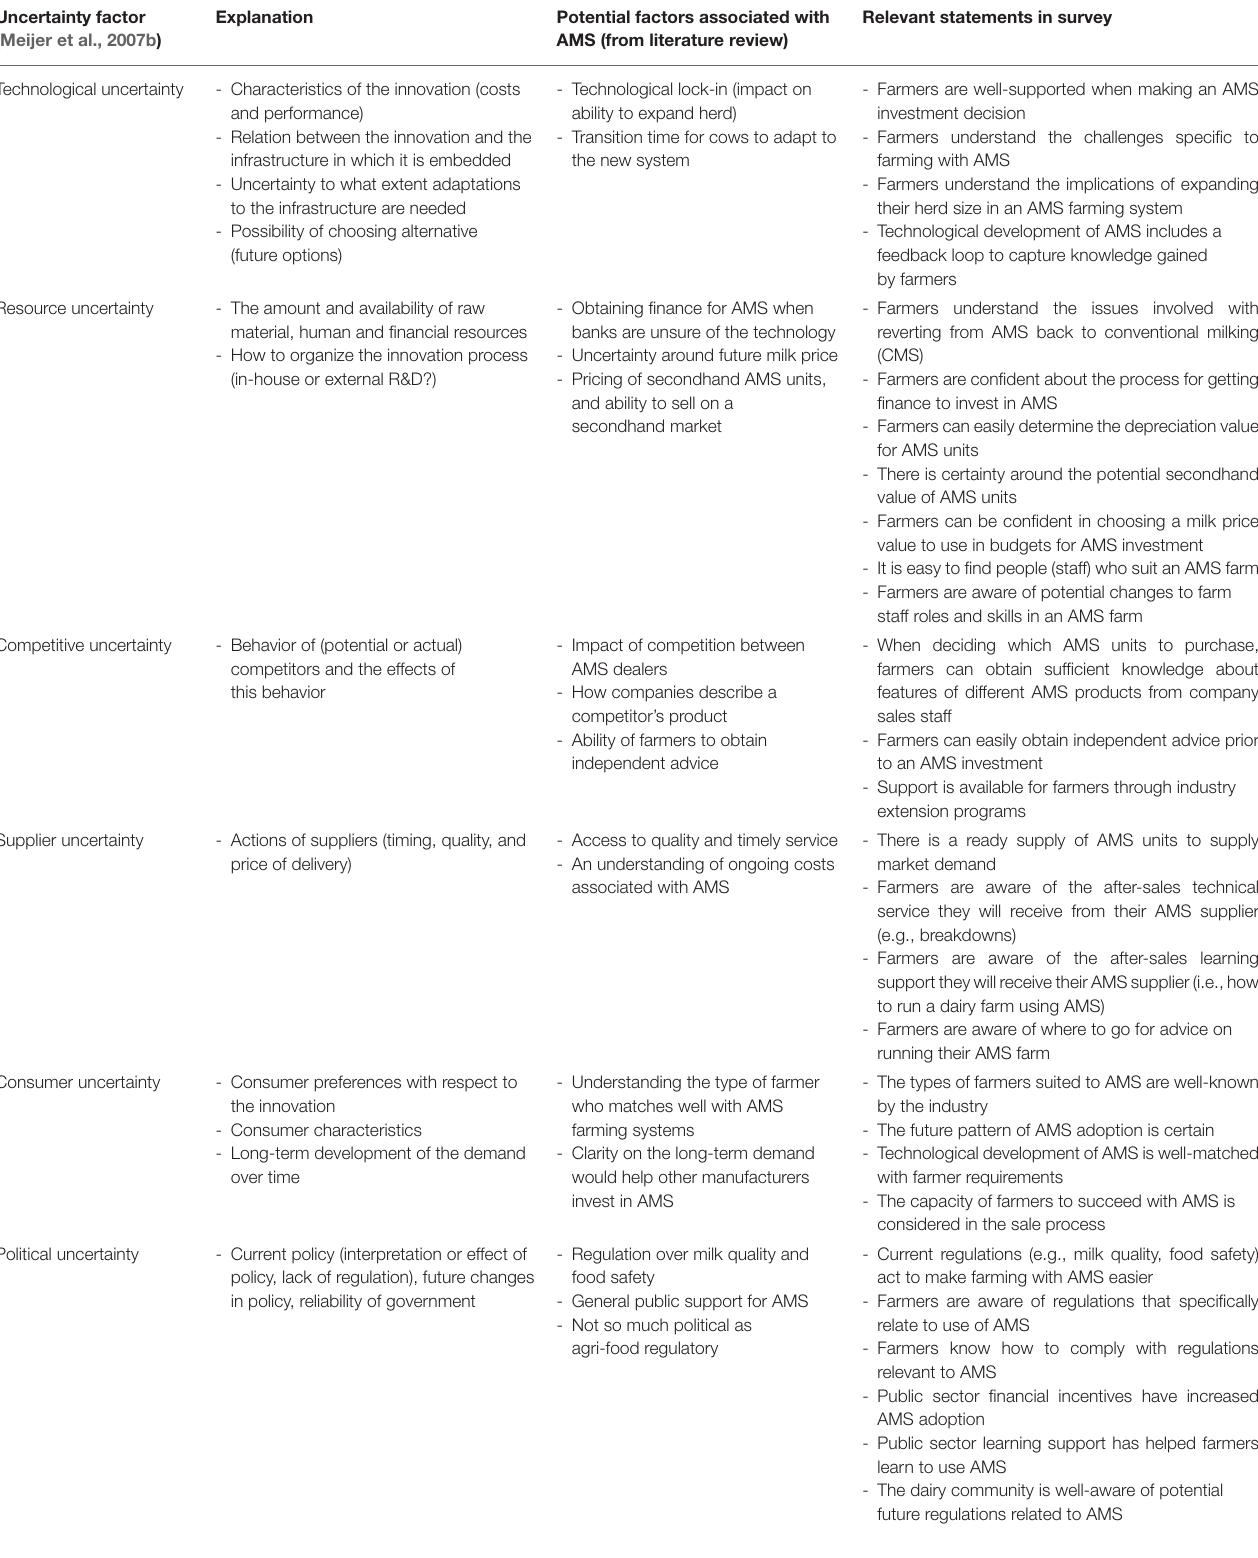
TABLE 2 | Survey questions asked in relation to the six forms of uncertainty within innovation systems [adapted from Meijer et al. (2007b)]. Uncertainty factor (Meijer et al.,